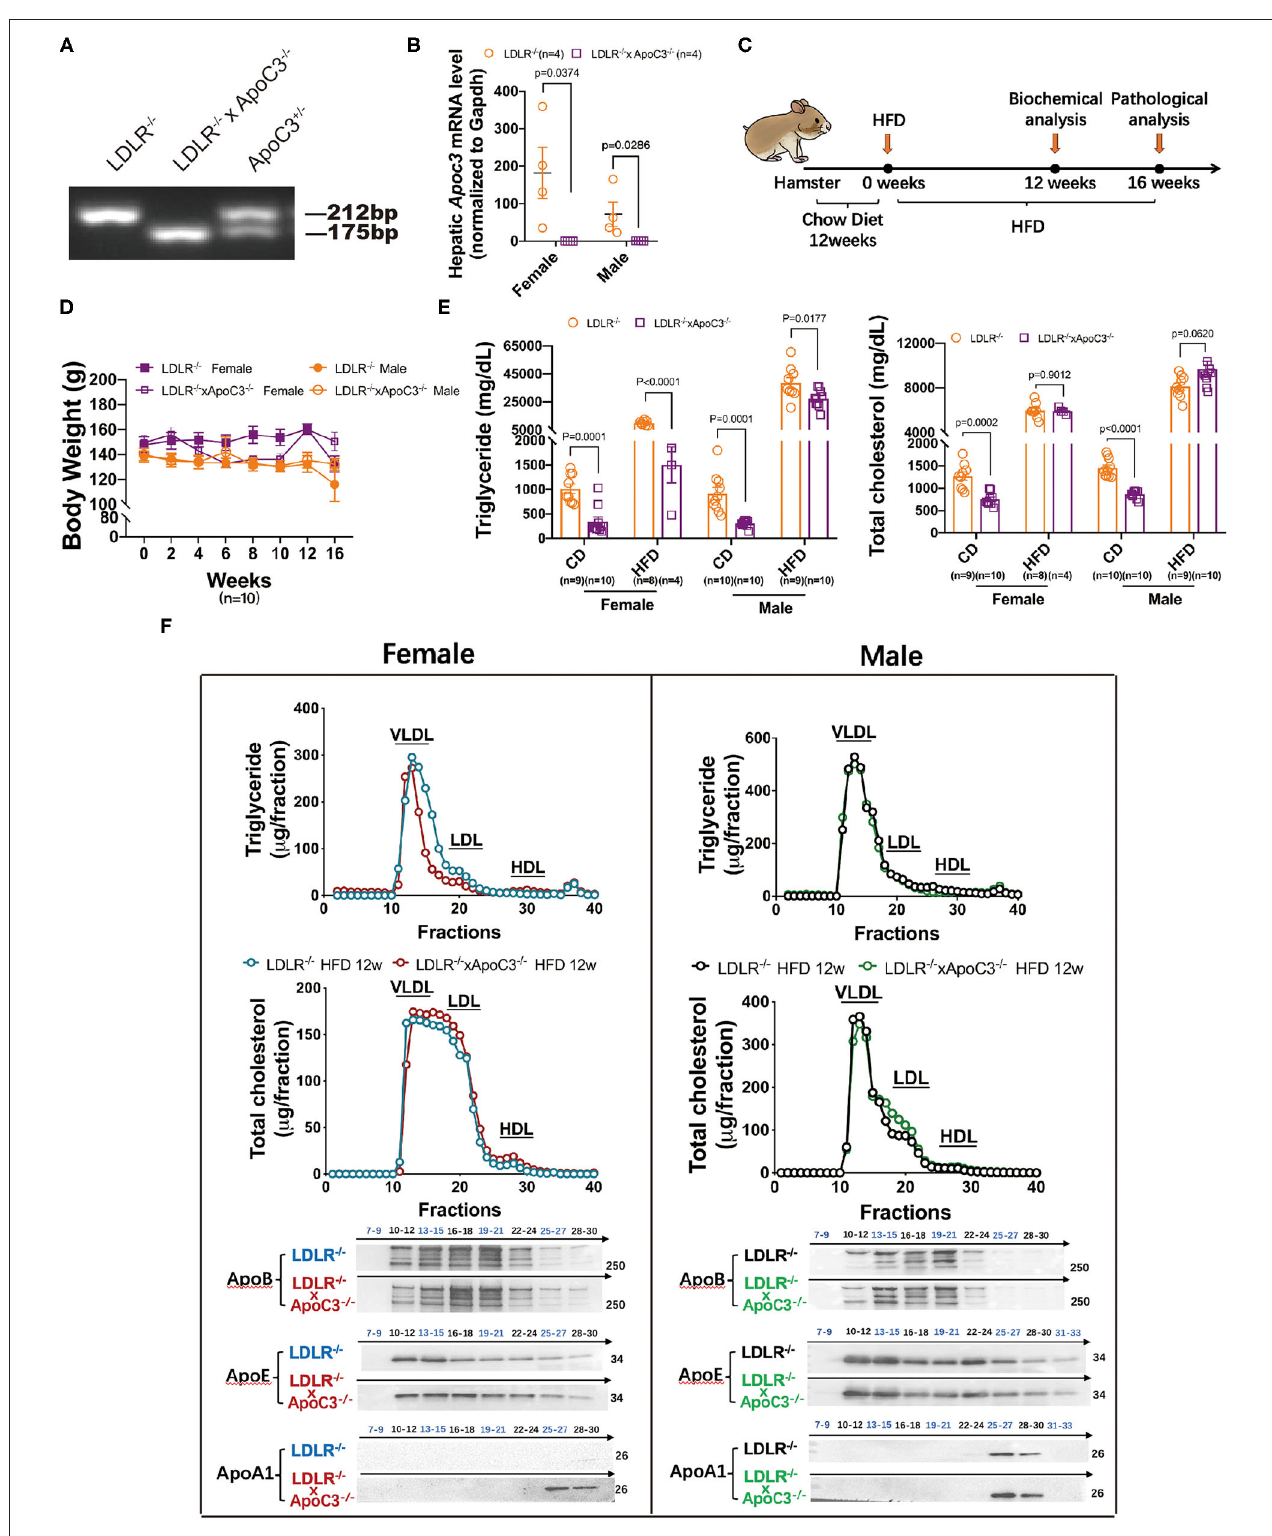
FIGURE 1 | Effects of ApoC3 deficiency on lipid metabolism in LDLR − / − hamsters. (A) Generation of DKO hamster model. (B) Hepatic Apoc3 mRNA expression levels were determined in indicated animals on chow at 12 weeks old. (C) Timeline of the whole experiments in this study. High-cholesterol/high-fat diet (HCHF) contains 0.5% cholesterol and 20% fat. (D) Measurement of body weight during the 16-week experiment. (E) Fasting plasma TG and TC levels in the indicated animal